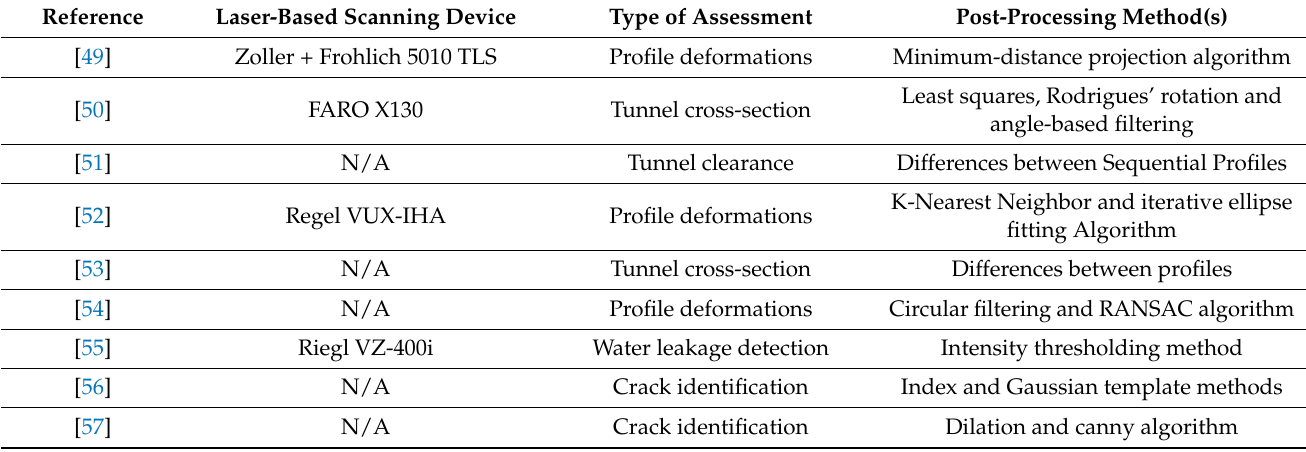
Table 3. A comprehensive summary of LiDAR-based SHM for